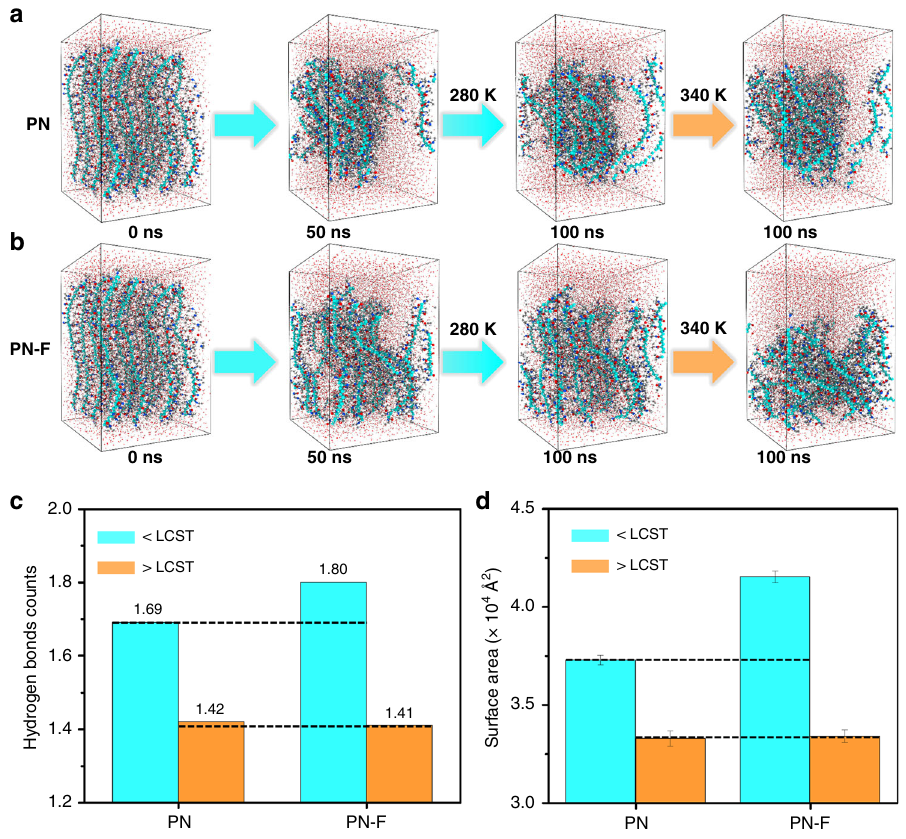
Fig. 4 Simulation results of the coil – globule behavior of PN and PN-F in water environment. a , b Snapshots of PN and PN-F, after equilibration at 280 K over 100 ns and heating at 340 K over another 100 ns. Both PN and PN-F systems consist of 16 PNIPAm chains and 7680 water molecules: hydrogen atoms are depicted in white, oxygen atoms in red, nitrogen atoms in deep blue, backbone carbon atoms in light blue, and other carbon in gray. c Normalized number of hydrogen bonds in completely equilibrated PN and PN-F systems at 280 and 340 K. d Total water-accessible surface area of PN and PN-F at 280